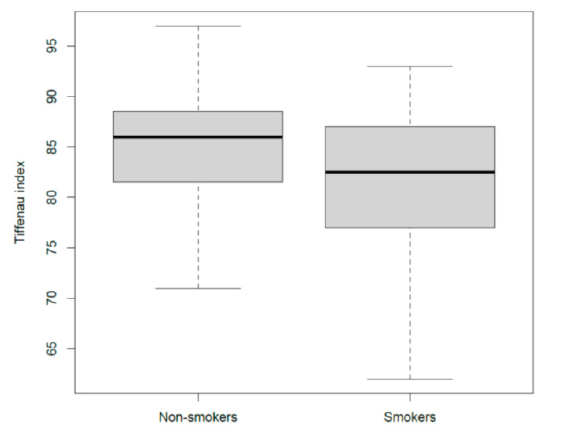
Figure 2. Correlation between FEV1 and PNIF. PNIF: peak nasal inspiratory flow; FEV1: forced expiratory volume in the 1st second.